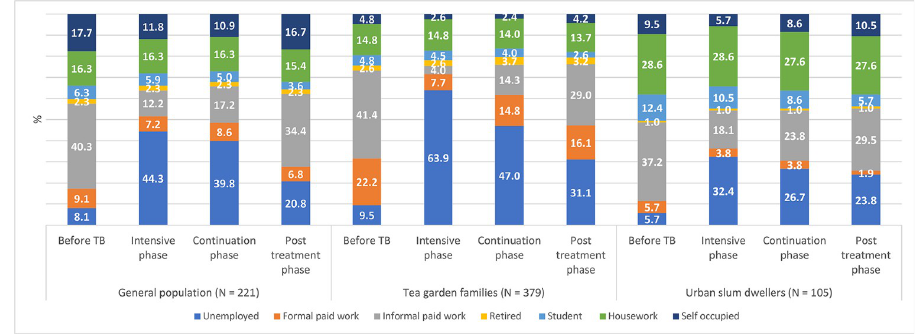
Fig 1. Employment status of the sampled patients at different